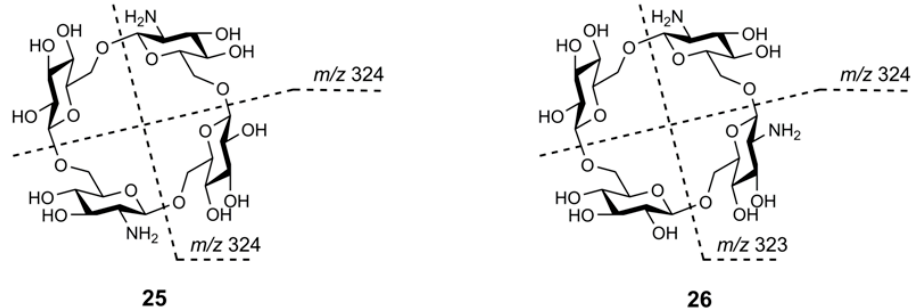
Figure 17. Structural formulas of cyclobis-(1 → 6)-( β - D -glucopyranosyl)-(1 → 6)-(2-amino-2-deoxy- β - D -glucopyranosyl) 25 and cyclo-(1 → 6)-(2-amino-2-deoxy- β - D -glucopyranosyl)-(1 → 6)-(2-amino-2-deoxy- β - D -glucopyranosyl)-( 1 → 6)-( β - D -glucopyranosyl)-(1 → 6)-( β - D -glucopyranosyl) 26 .